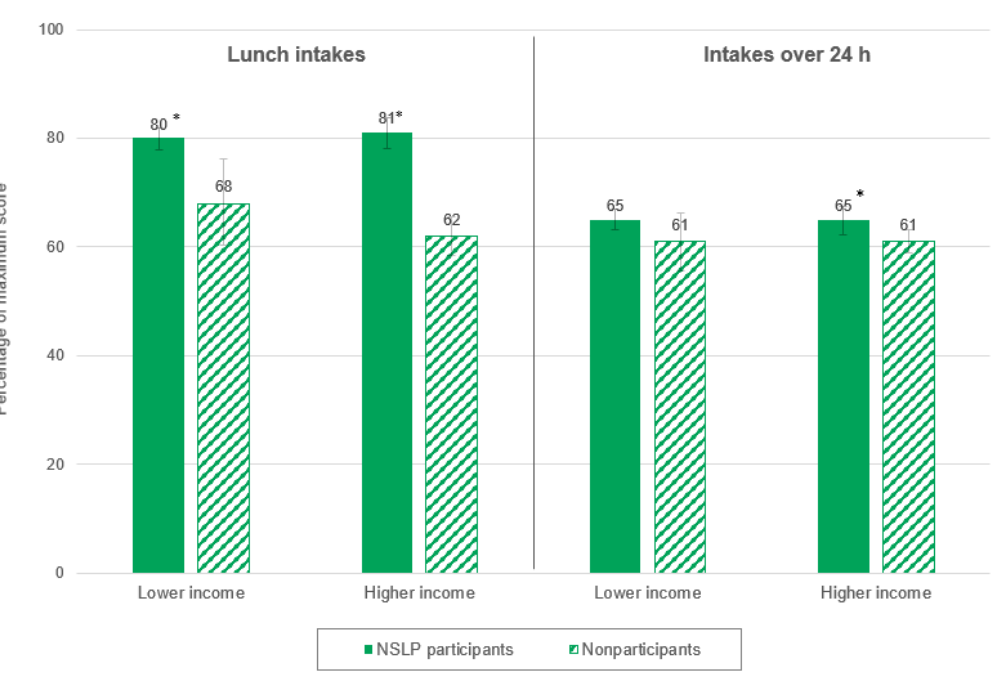
Figure 1. Differences between NSLP participants and nonparticipants in total HEI-2010 scores at lunch and over 24 h, by household income. * Within an income subgroup, the difference between NSLP participants and nonparticipants was significantly different from zero at the p < 0.05 level. HEI = Healthy Eating Index; NSLP = National School Lunch Program.